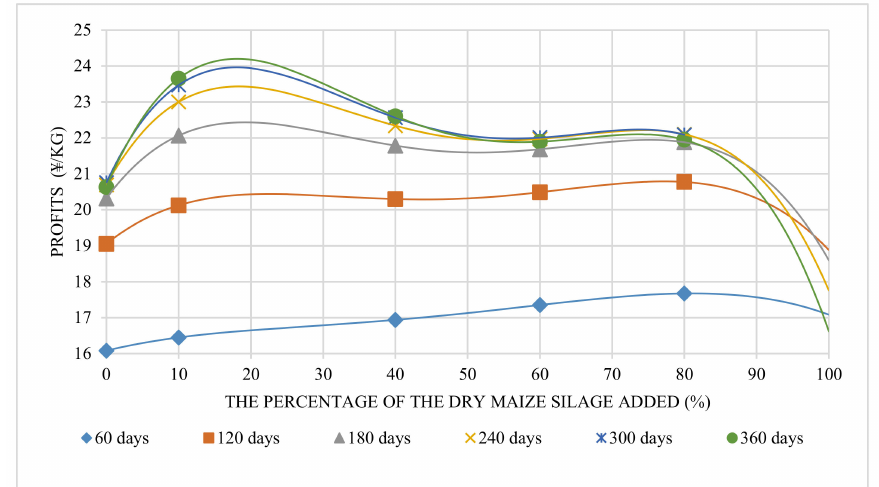
Figure 9. Predicted trends of profits gained with different percentages of sun-dried maize silage